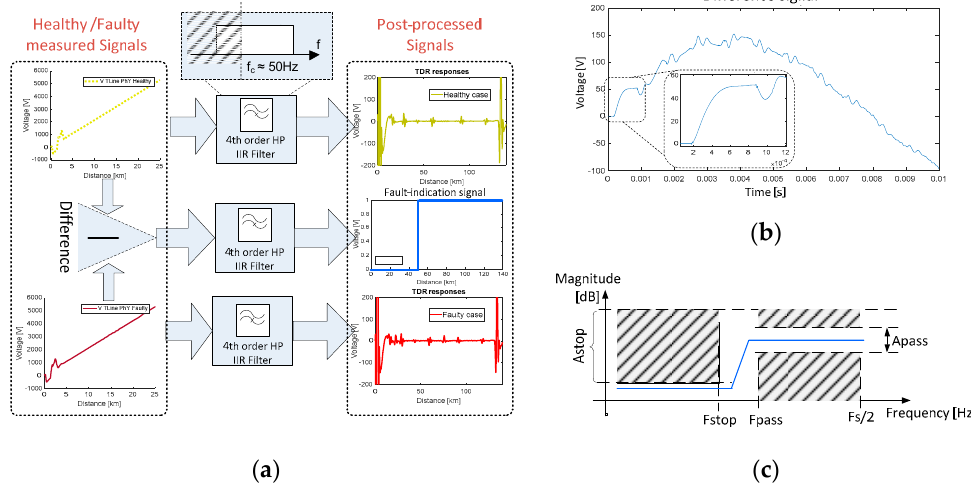
Figure 8. Data post-processing procedure design: ( a ) principle scheme and example waveforms, ( b ) example difference signal waveform, ( c ) digital high-pass filter design mask and parameters.